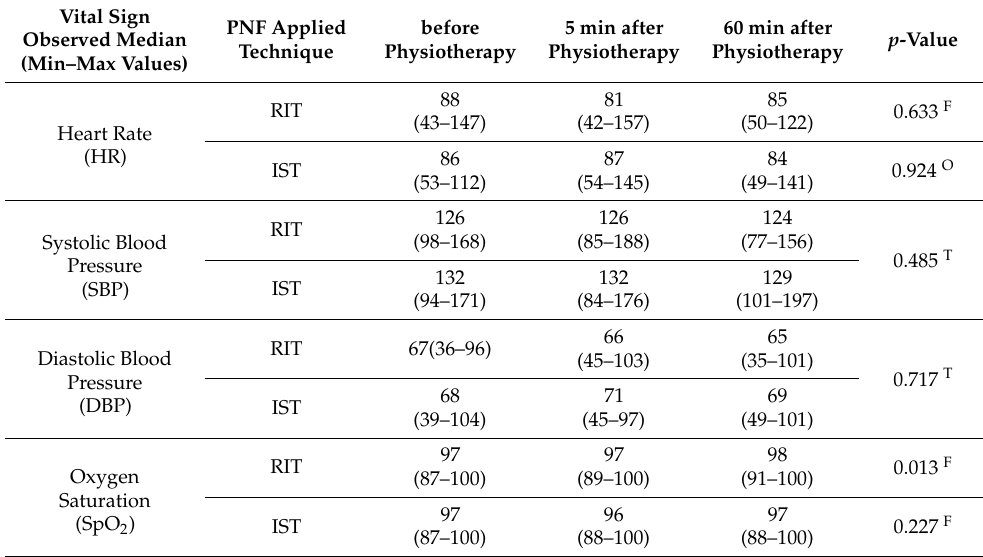
Table 2. HR, SBP, DBP, and SpO 2 before, and 5 and 60 min after, physiotherapy for the RIT and the